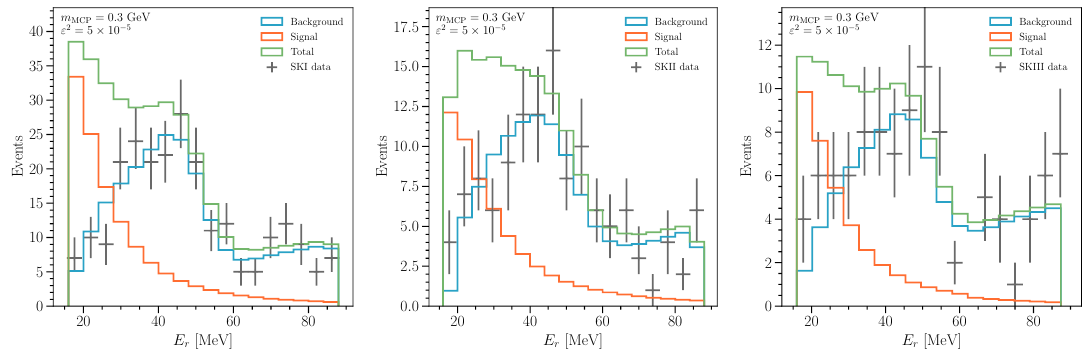
Figure 10 . Distributions for our millicharged particle search for the three stages of Super- Kamiokande. Data is shown as crosses and expected background is shown as a blue histogram. An example millicharge particle distribution is shown, for the same parameters, as an orange